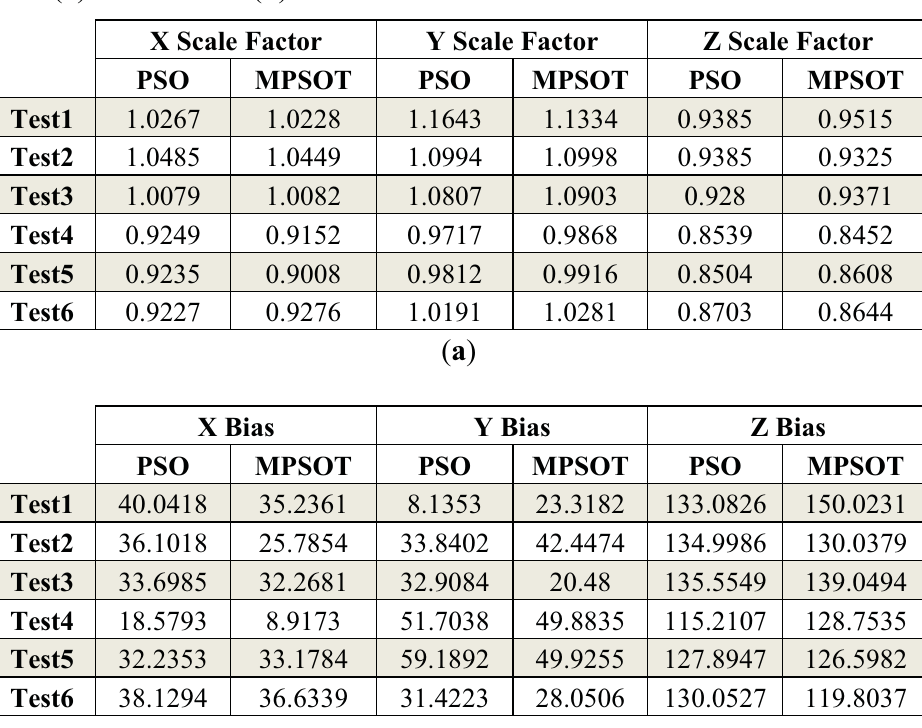
Table 4. Magnetometers parameters resulted from using the basic PSO and MPSOT in 3-D calibration. ( a ) Scale factor. ( b )